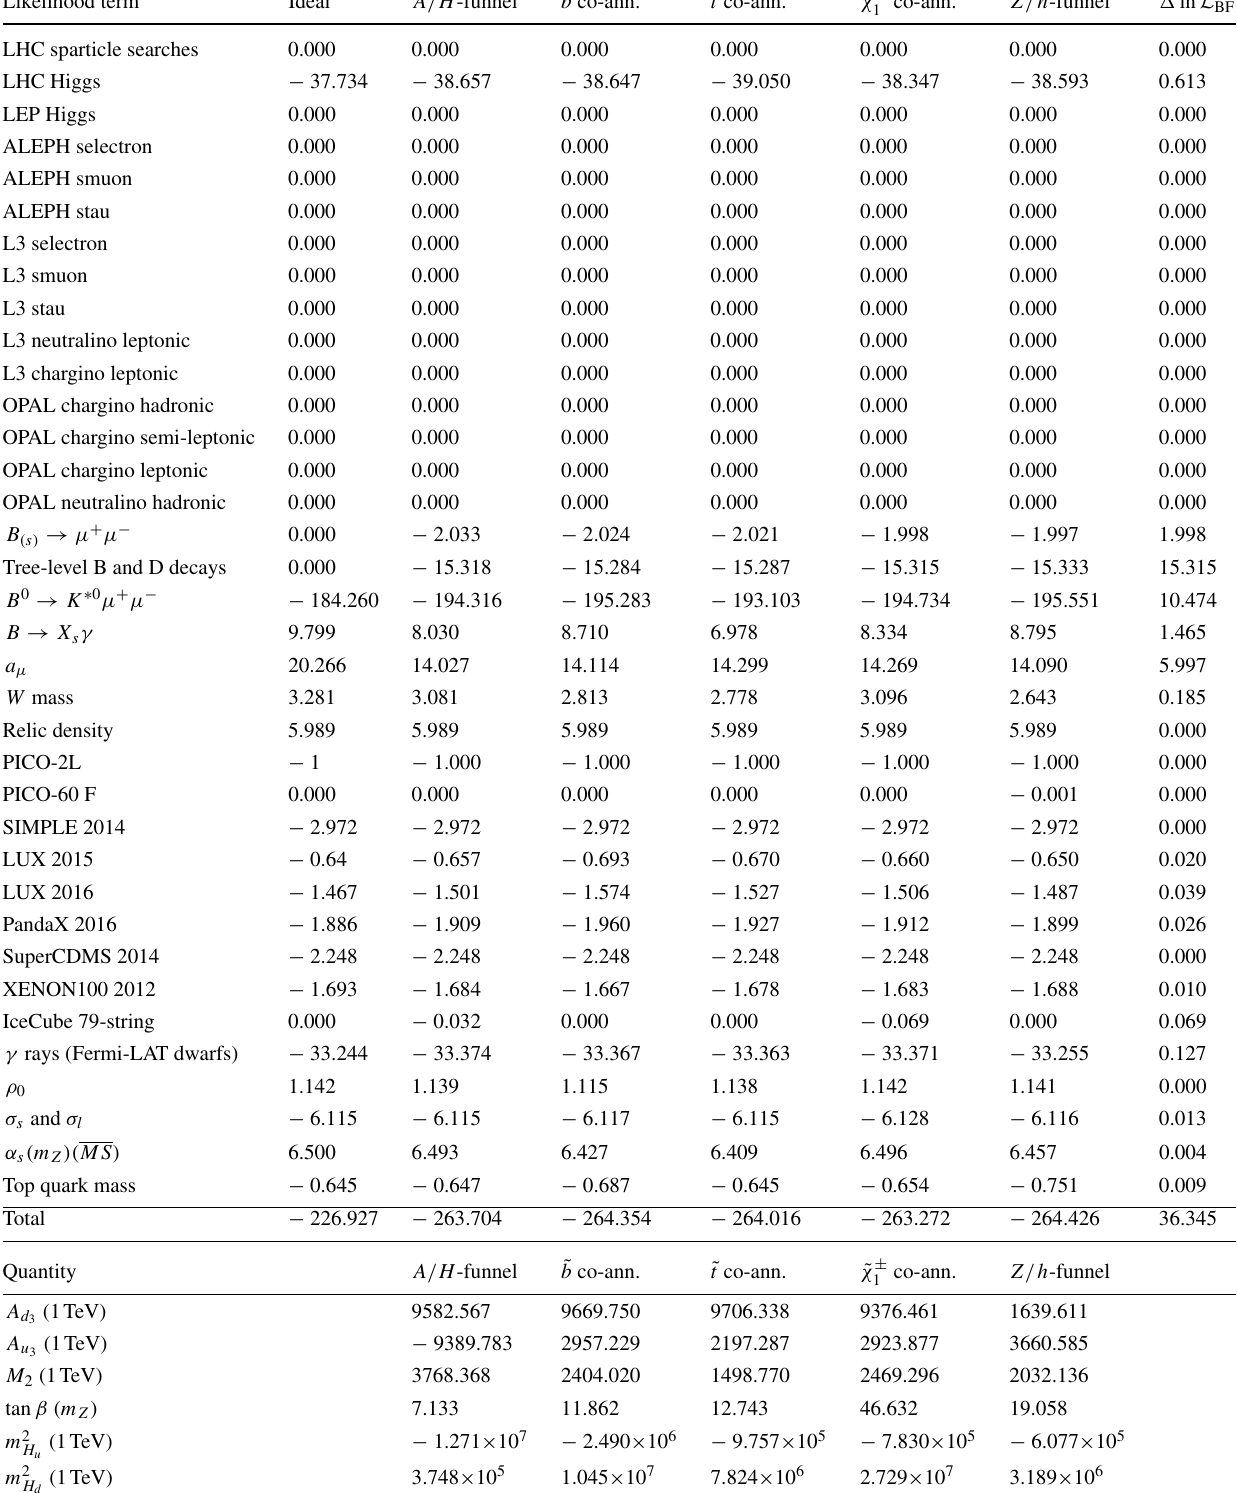
interpreting the mass spectrum. Other SM and astrophysical parameters are set to the fixed values given in Table 2. SLHA1 and SLHA2 files for the best-fit points can be found in the online data associated with this paper